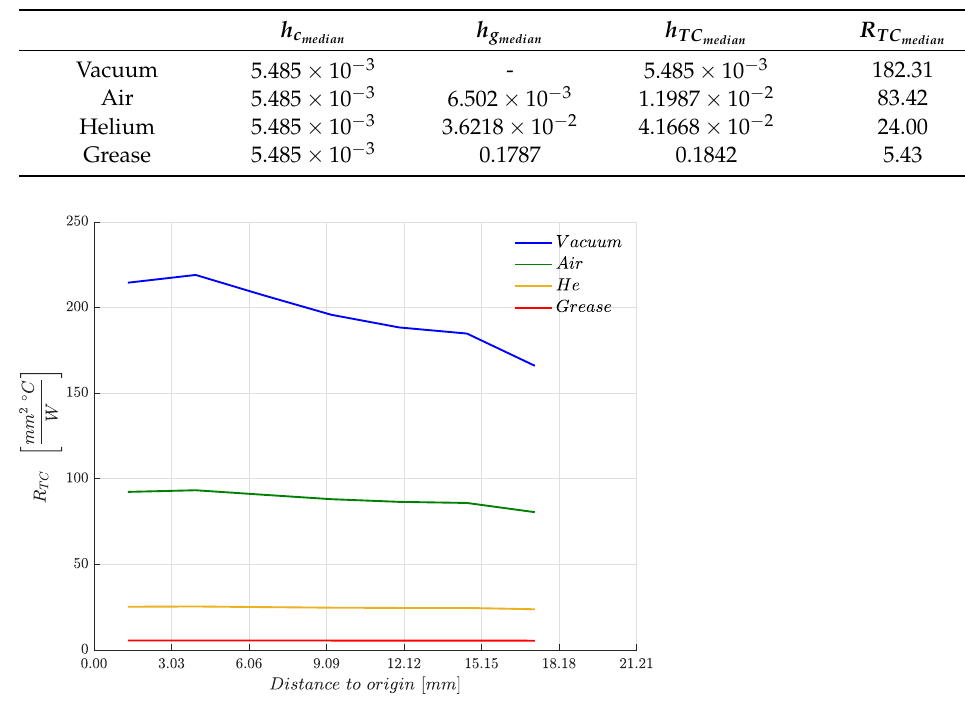
Table 8. Median microcontacts thermal contact conductance ( h c [W/ ◦ Cmm 2 ]) and TIM thermal conductance ( h g [W/ ◦ Cmm 2 ]) comparison for all TIMs studied calculated according to Equations (8) and (10).